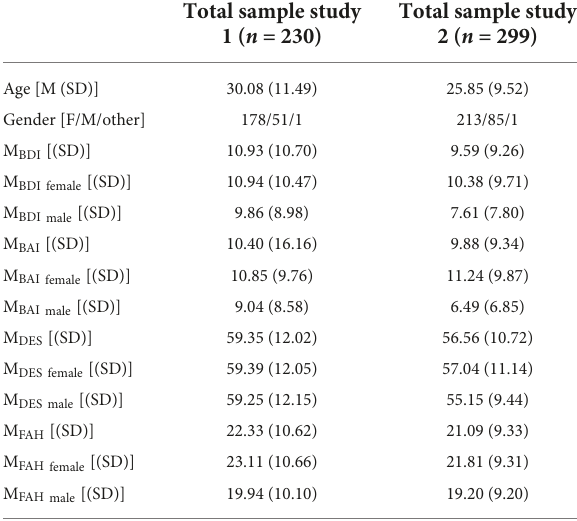
TABLE 1 Demographics: Mean and standard deviations of different variables involved in study 1 and study